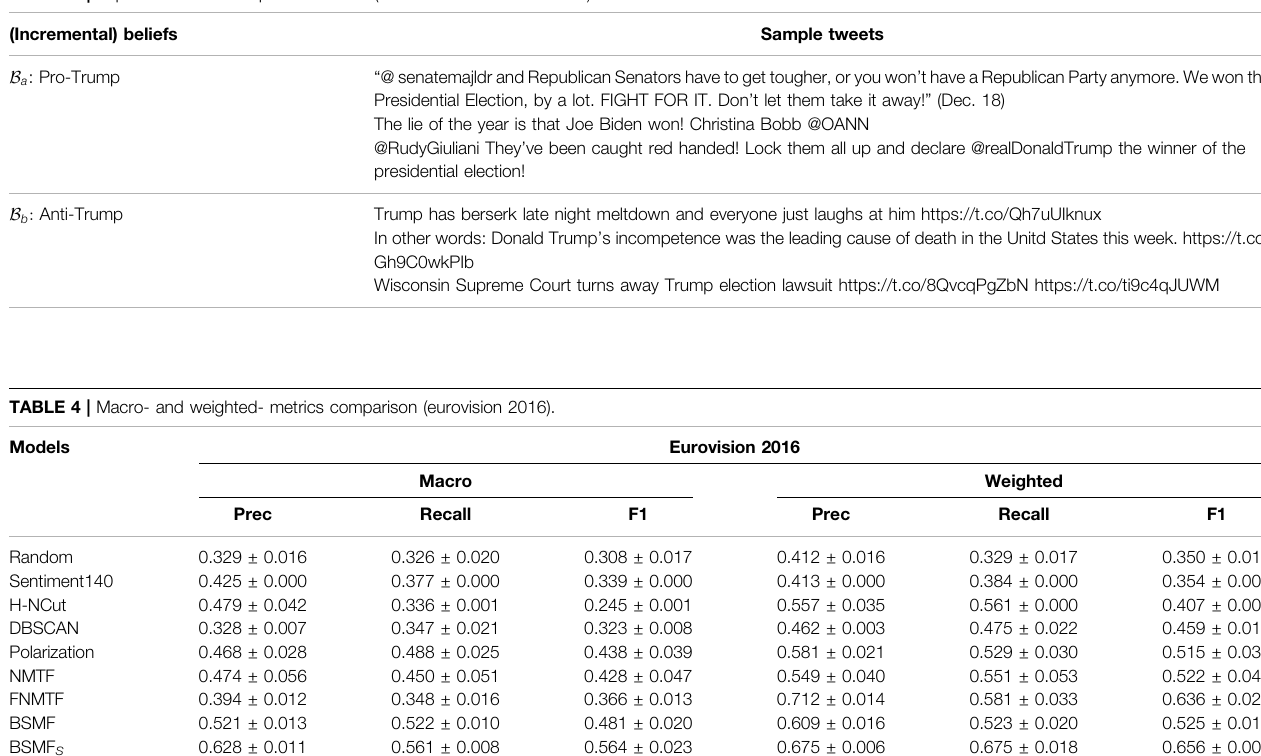
TABLE 3 | Top 3 tweets from separated beliefs (United States election 2020).